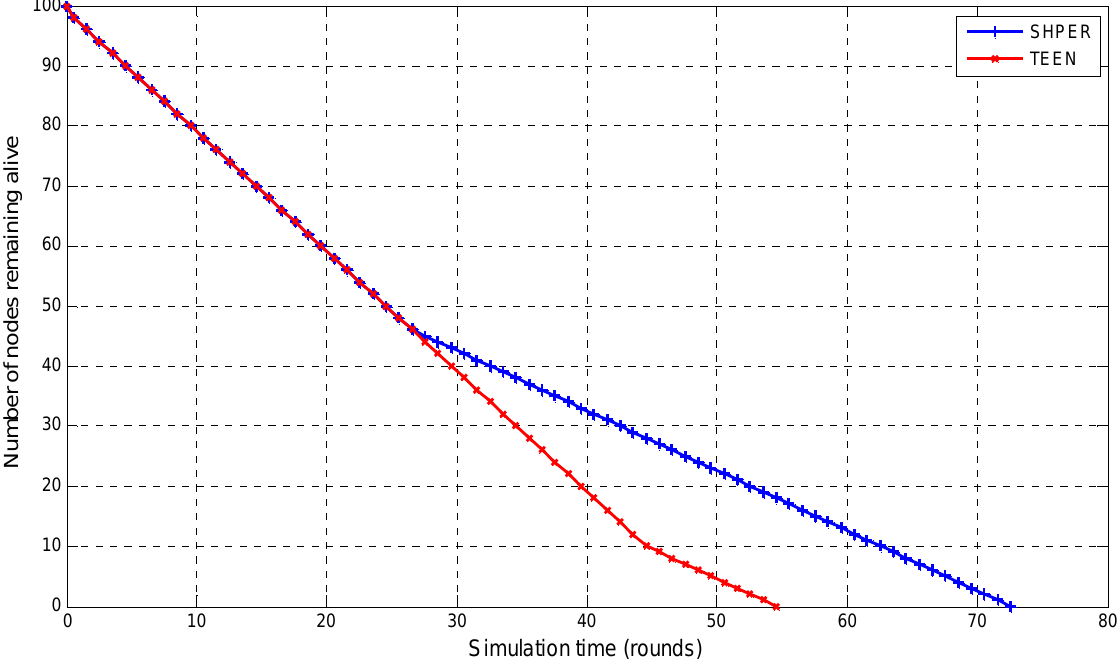
Figure 12. Comparative depiction of the nodes remaining alive over the simulation time steps in SHPER and TEEN [ Er (0)  [0.1,0.5] J, D = 300 i